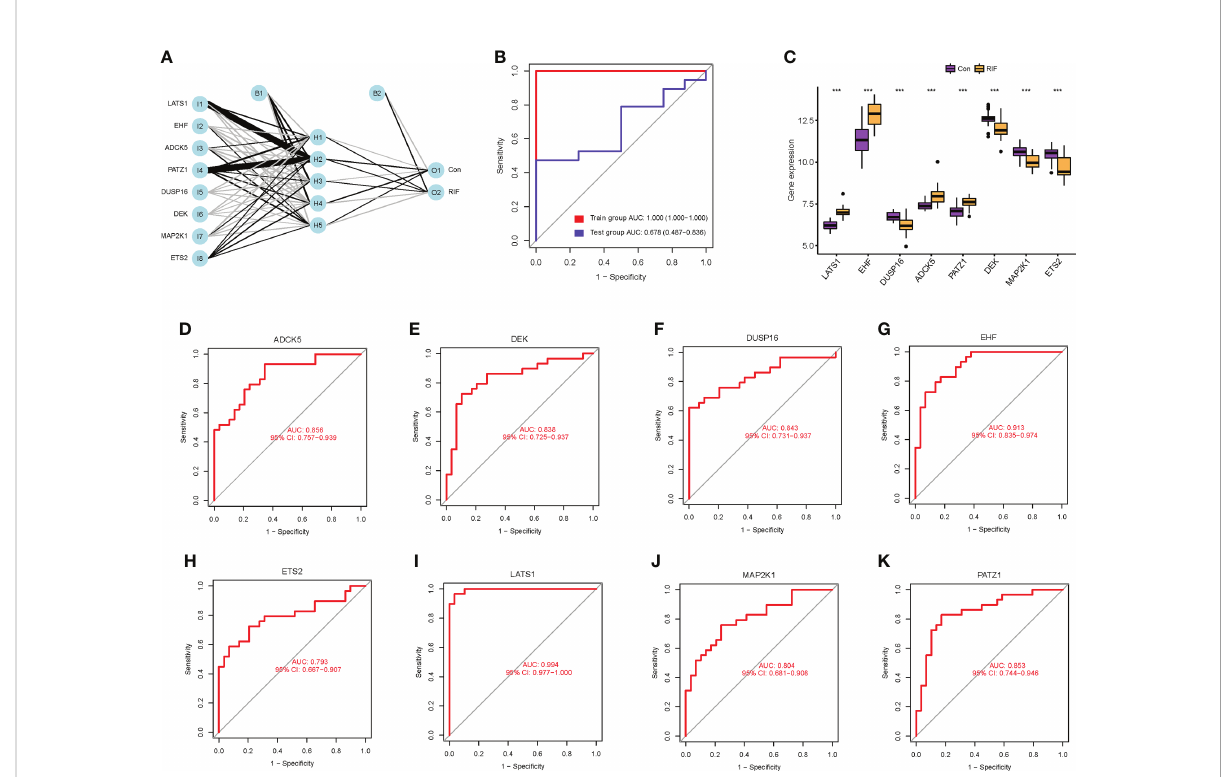
FIGURE 3 Diagnostic value of cellular senescence-associated DEGs in RIF. (A) The neural network model: I1 – I8 are the input layers (the score and weight of eight RIF signature genes), H1 – H5 are the hidden layers, and O1 – O2 are the output layers (sample attributes). (B) The receiver operating characteristic (ROC) curves for evaluating the diagnostic ef fi cacy of the neural network model in the GSE26787 and GSE111974 (training set) and GSE106602 (testing set). (C) The mRNA expression pro fi ling analysis of the eight RIF signature genes. (D – K) The ROC curves of the RIF signature genes. *** represents P < 0.001 compared with the control